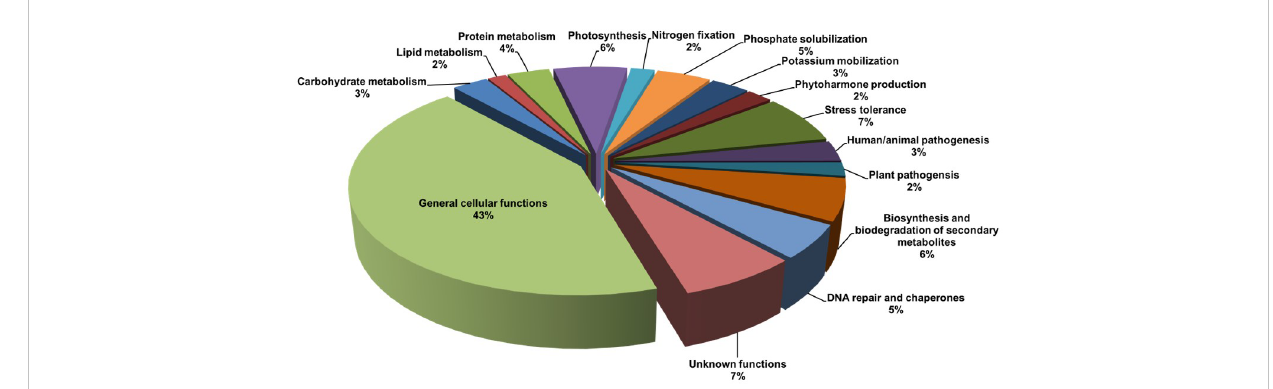
FIGURE 4 Functional characterization of the rhizosphere metagenome of L. camara L., predicted through PICRUSt